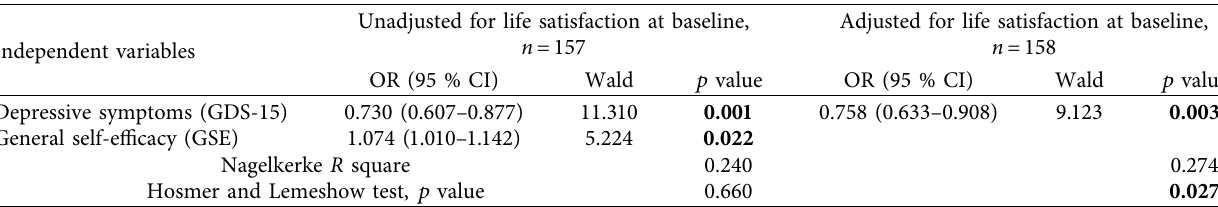
OR � odds ratio; CI � confidence interval; GSE � General Self-Efficacy Scale (10–40, higher � better); Walk-12G � Generic Walk-12 (0–42, higher � worse). Life satisfaction was assessed with item 1 of the Life Satisfaction Questionnaire (scored 1–6; higher � better), and scores were dichotomized into not satisfied (1–4; coded as 0) and satisfied (5-6; coded as 1). The following 7 independent variables were initially included in the models (backward method): sex; education; general self-efficacy; motor symptoms; walking difficulties; fall-related activity avoidance; difficulties with, or need help in activities of daily living. Statistically significant p values (0.05) are presented in bold. Table 3: Model 2: multivariable logistic regression analyses with life satisfaction (3-year follow-up) as the dependent variable (personal factor, motor-related aspects, and depressive symptoms as independent variables).